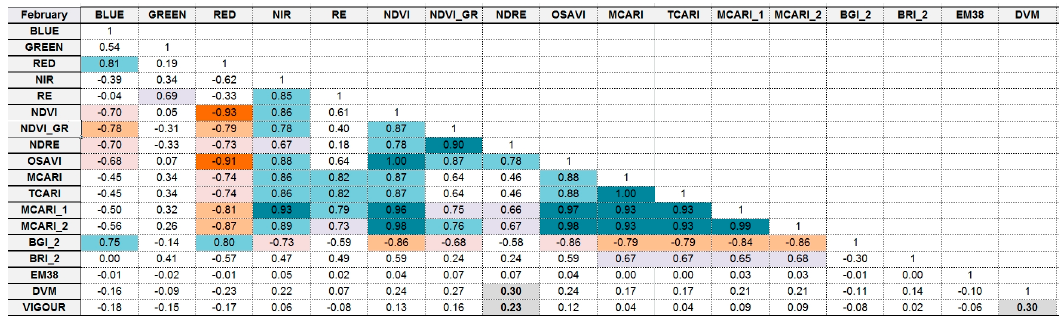
Figure 15. Pearson’s correlation coefficient matrix showing the strength of the relationship between the February 2017 multispectral vegetation indices and expert and digital vigour assessment. Orange colours indicate negative correlation, blue colours indicate positive correlation, and intensity of colour indicates relative strength.